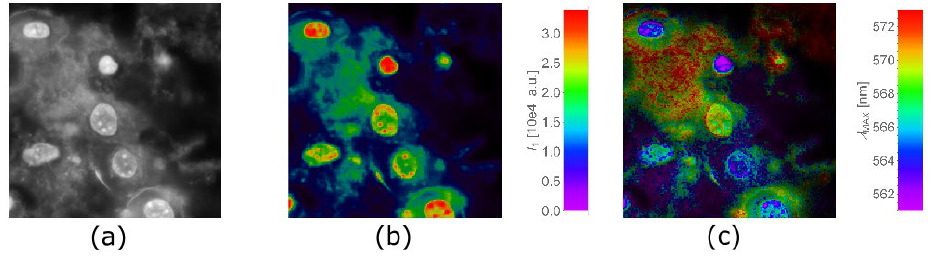
Figure 3. The nuclei of NIH/3T3 cells filled with QCDs. ( a ) Fluorescence intensity image generated by summing up all the images in the λ -stack (FMS, field of view 132 µ m); ( b ) False colored maps of intensity; ( c ) Spectral peak position obtained from spectral fitting. Concentration of QCDs was 400 µg/mL with an incubation time of 24 h.